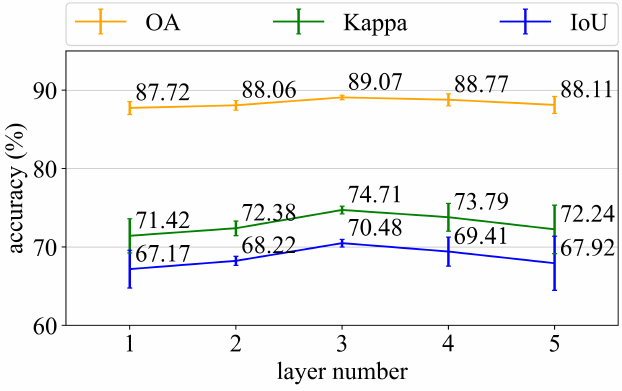
Figure 13. Quantitative comparison of models with different depths.